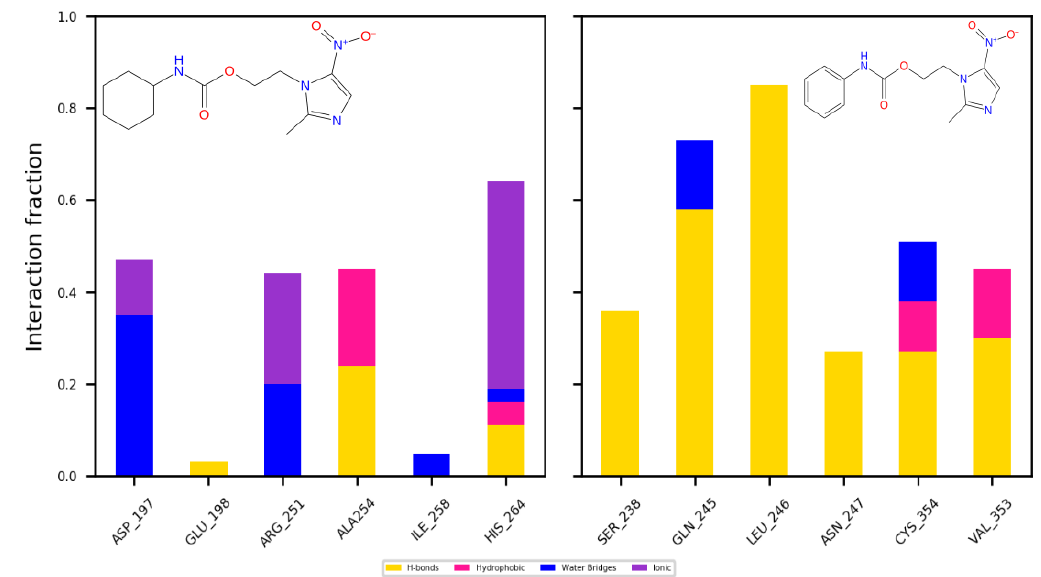
Figure 8. Protein–ligand interactions determined from the molecular dynamics of β -tubulin/nitroimidazole complexes: H-bond (yellow), hydrophobic (pink), water bridges (blue), and ionic (violet) interactions.